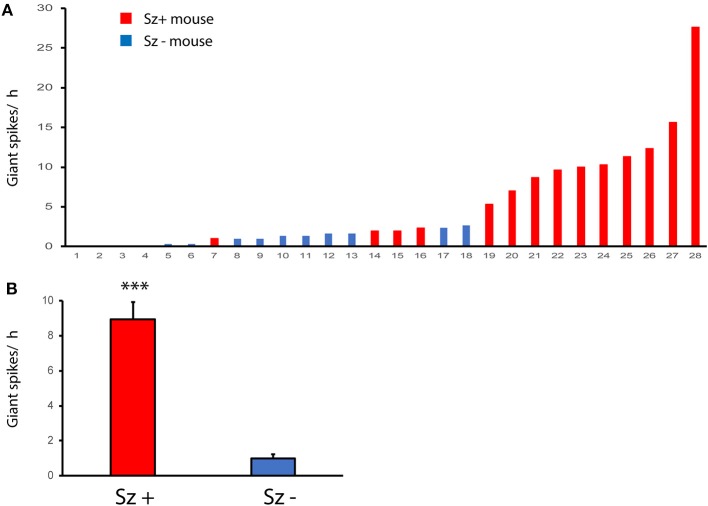
Giant spikes are related to the risk of seizures. (A) Number of giant spikes per hour in individual APP/PS1 mice with identified seizures (Sz +, n = 14) and seizure free mice (Sz -, n = 14) during a 2-week video-EEG recording. The dashed line indicates a threshold above which all mice express seizures. (B) The same dataset as in (A) but comparison between Sz+ and Sz – groups. ***Significant difference in the number of giant spikes, Mann–Whittney test, p < 0.001.